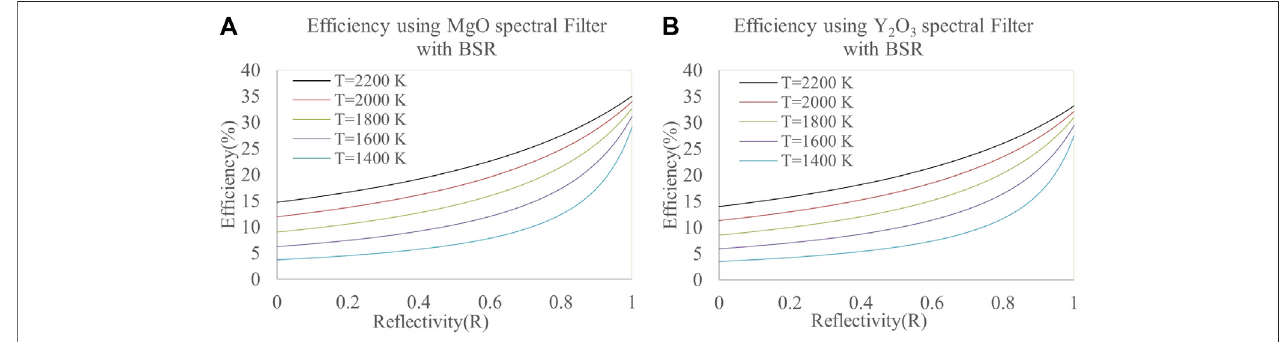
FIGURE 13 | (A) BSR used along with the MgO spectral fi lter. The ef fi ciency of the module increases with the increasing T. (B) Effect of increasing emitter temperature on the ef fi ciency ( η ) of a real 0.25 cm 2 InGaAs TPV cell (EQE = 0.7097) with respect to the re fl ectivity R of the BSR used along with the Y 2 O 3 spectral fi lter.